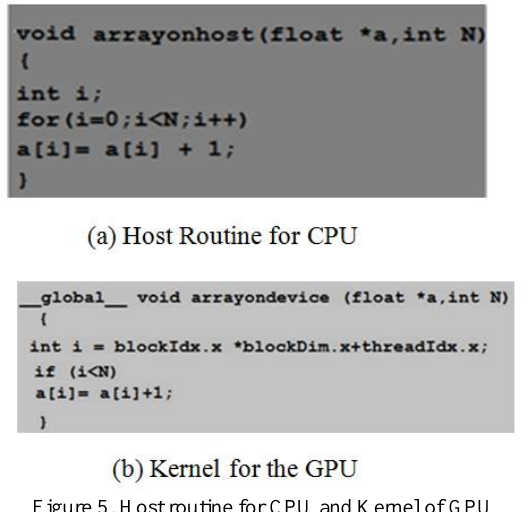
Figure 5. Host routine for CPU and Kernel of